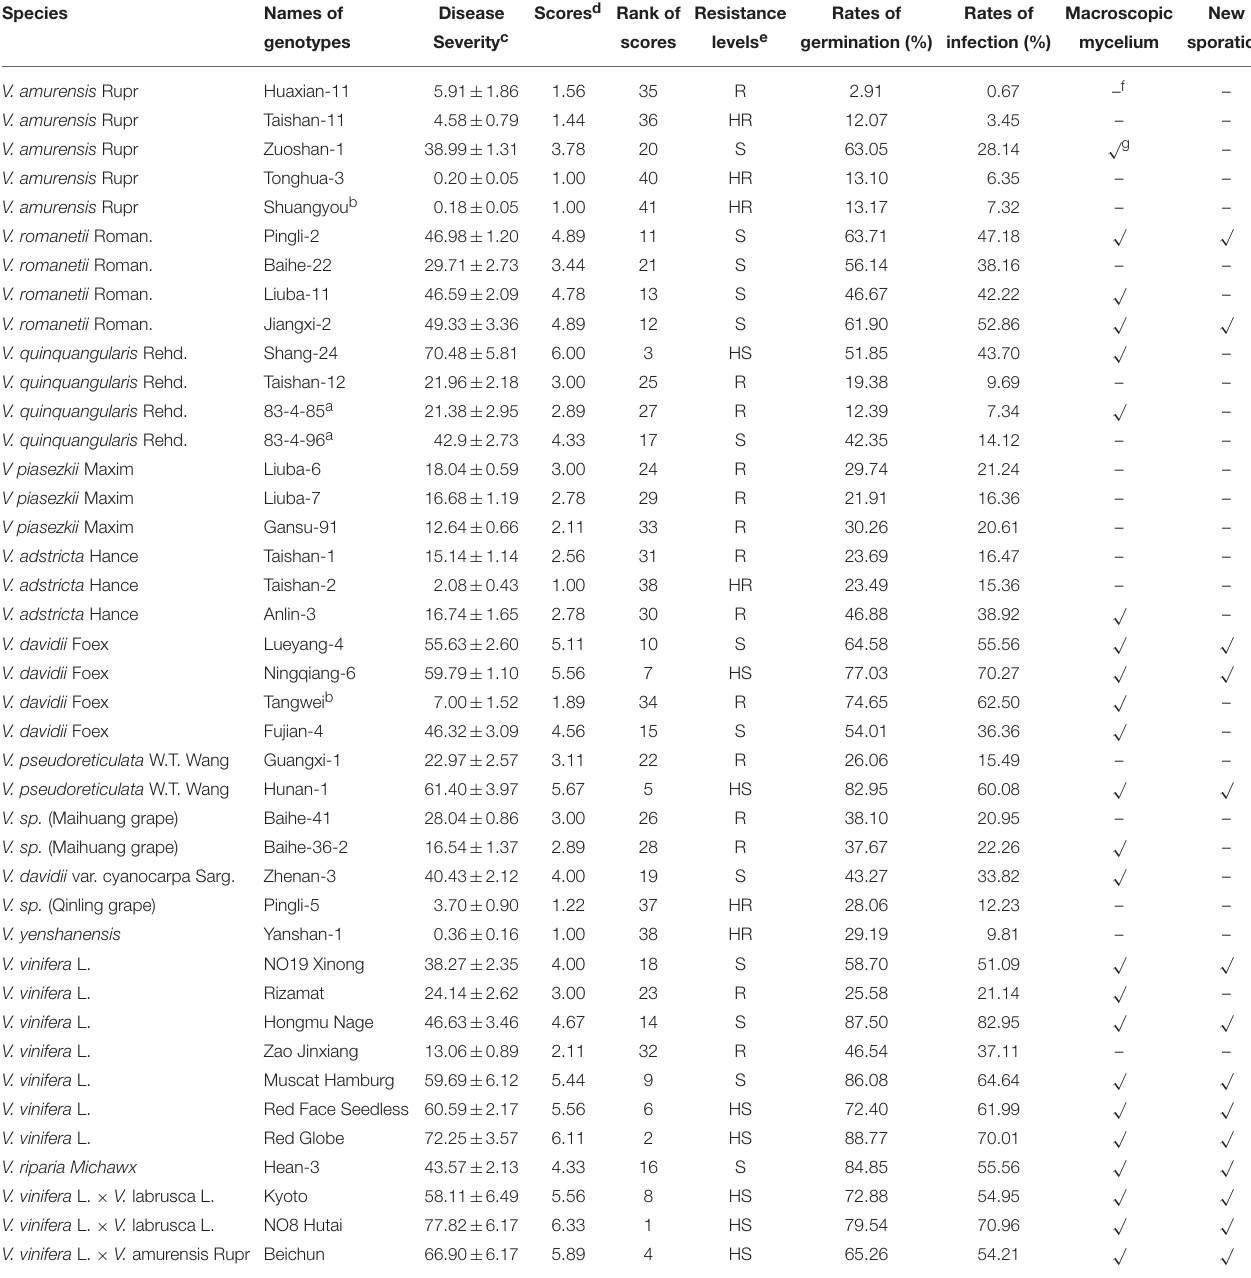
TABLE 1 | Laboratory evaluation results (including macroscopic and light microscopic examination) of 41 Vitis genotypes against Botrytis Cinerea from 2011 to 2013. Species